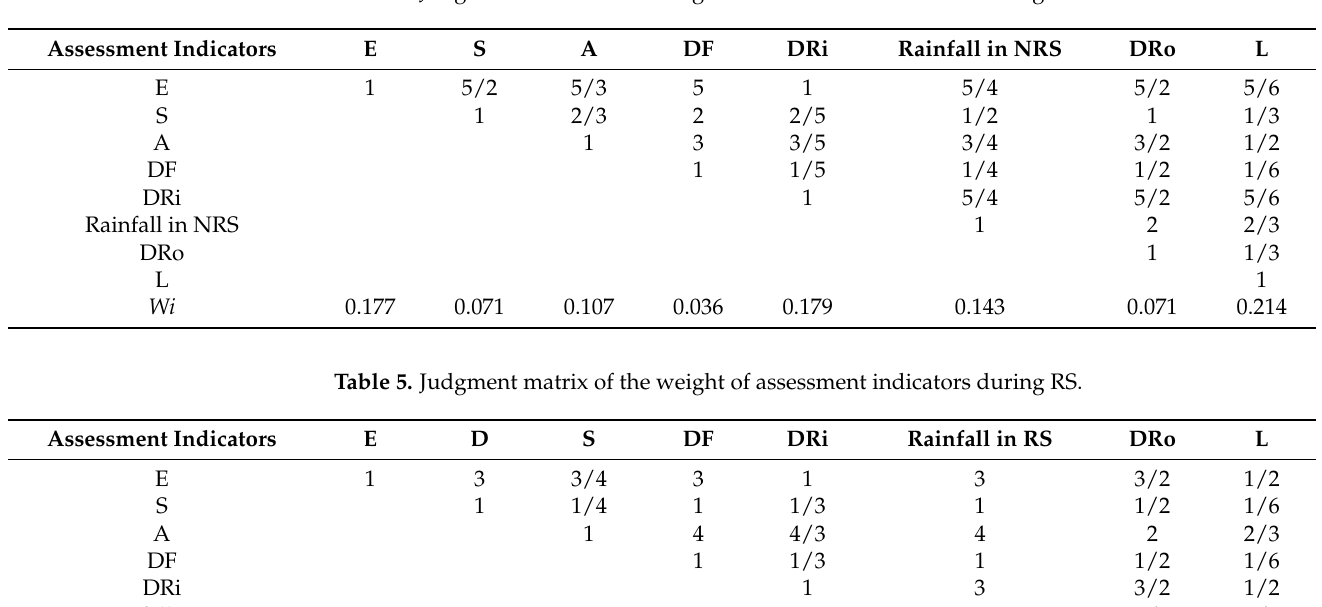
Table 4. Judgment matrix of the weight of assessment indicators during RNS.